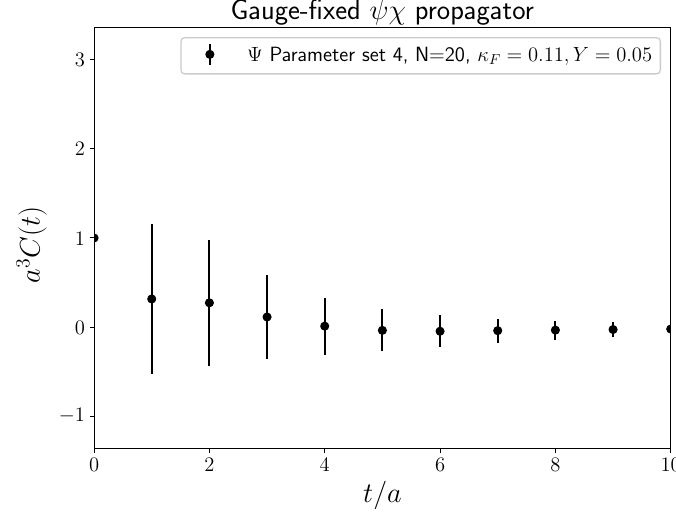
Figure 3: Example for the nonoverlap of ψ and χ for system 4 on a 20 4 lattice at κ = 0.11 and Y = F